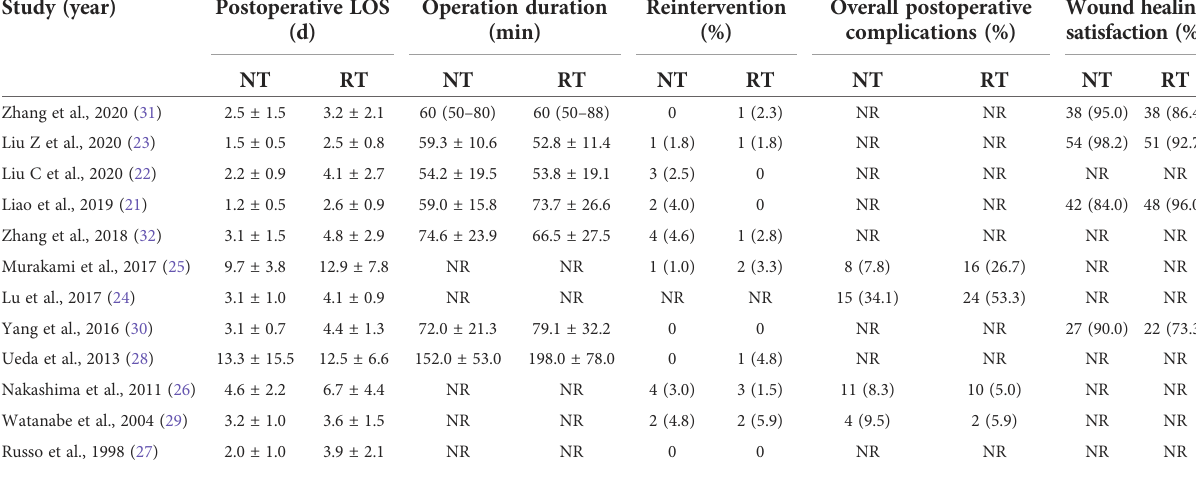
TABLE 2 Perioperative outcomes of the included